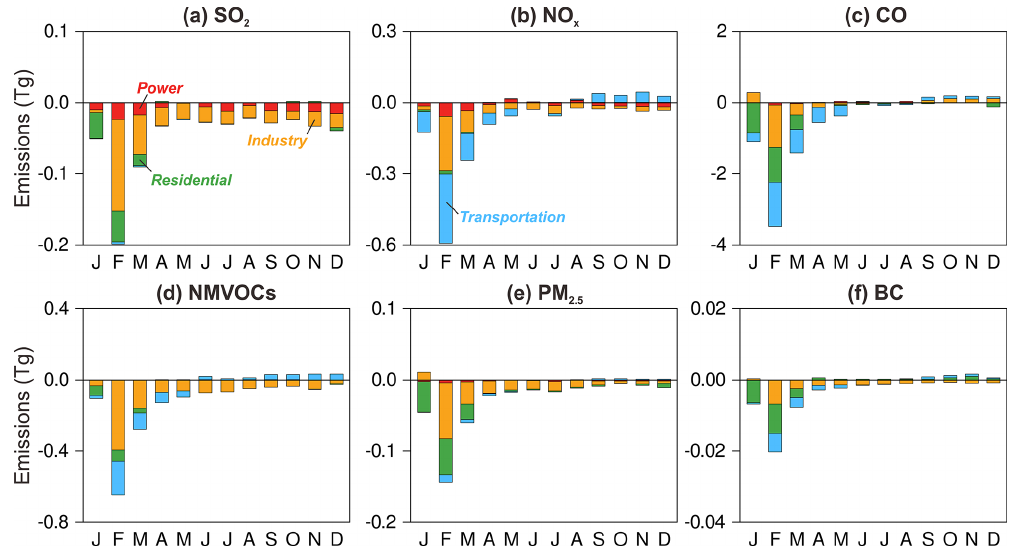
Figure 5. Differences in monthly emissions between 2019 and 2020 by source sector. Six pollutants are presented including SO 2 (a) , NO x (b) , CO (c) , NMVOCs (d) , PM 2 . 5 (e) , and BC (f) . Each bar represents the results of monthly emissions in 2020 minus those in 2019. The color of stacked bars represents the source sectors of power (red), industry (yellow), residential (green), and transportation